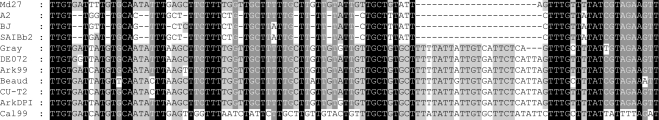
Comparison of 5′ terminus of 3′ untranslated region (UTR) of Md27 with some selected strains of IBV*.Nucleotide deletion of Md27 at 3′UTR is clearly shown. Sequences were compared using Gendoc software.*Nucleotides of Md27 shown are starting from 86th nucleotide after the stop codon of N gene.